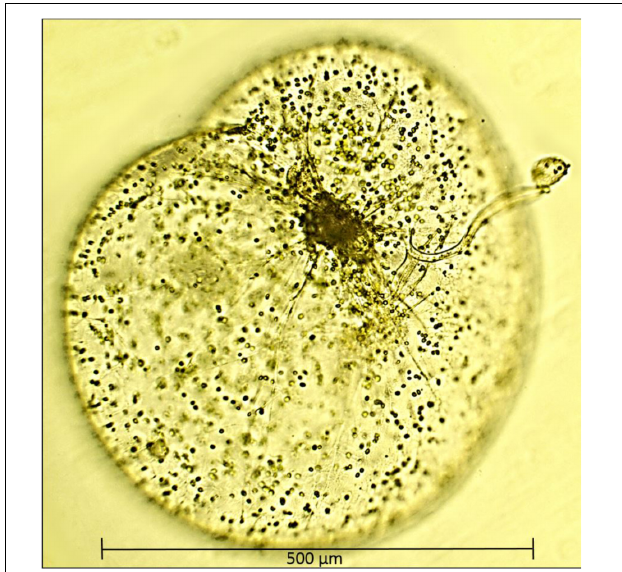
FIGURE 1 | A single cell of Noctiluca scintillans with free-swimming endosymbionts Protoeuglena noctilucae using its tentacle to capture algal cells for feeding. Image was produced with a epifluorescence microscope (OMAX 40X–2500X) with a 40 ×